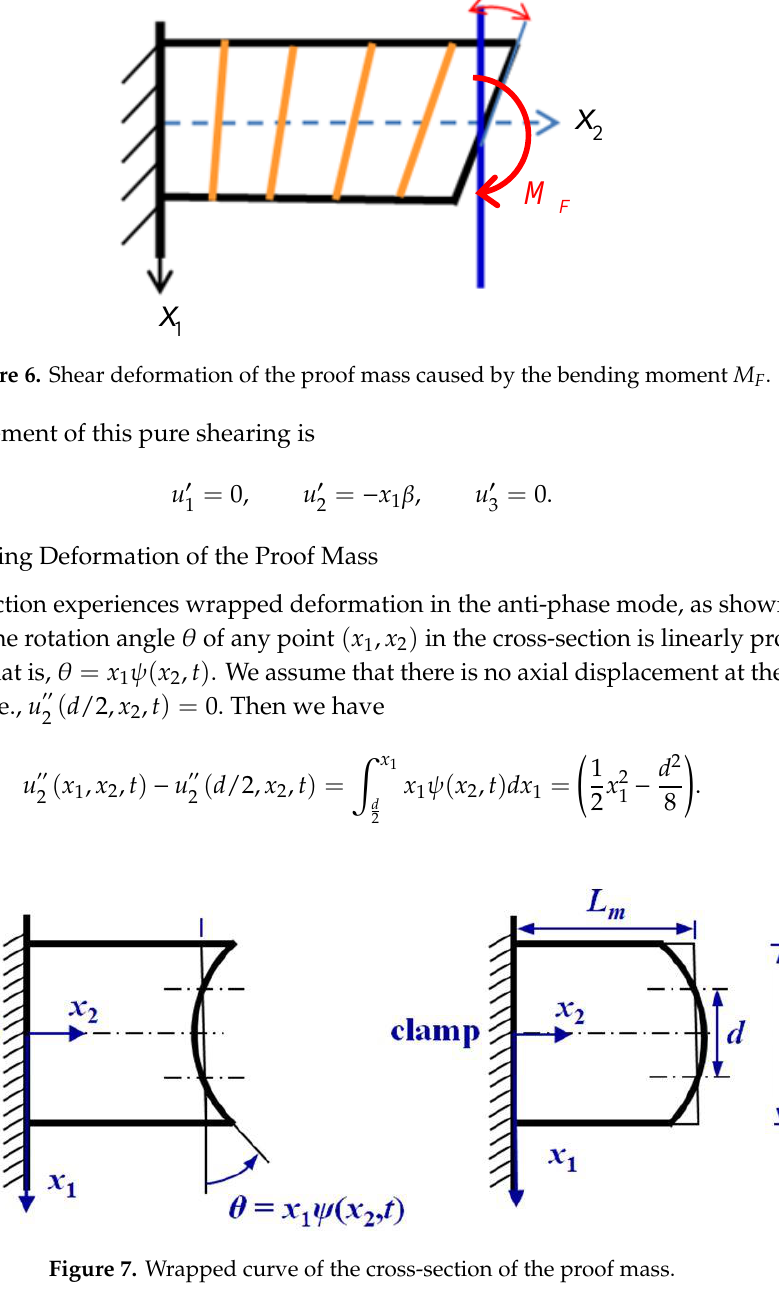
Figure 6. Shear deformation of the proof mass caused by the bending moment